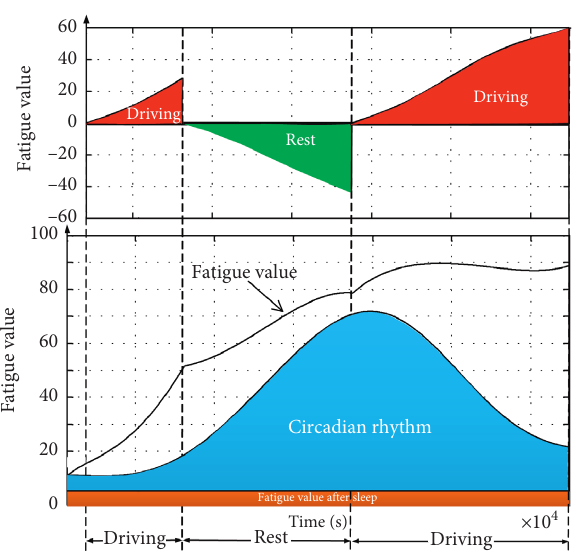
Figure 6: Sketch of the fatigue value variation corresponding to each